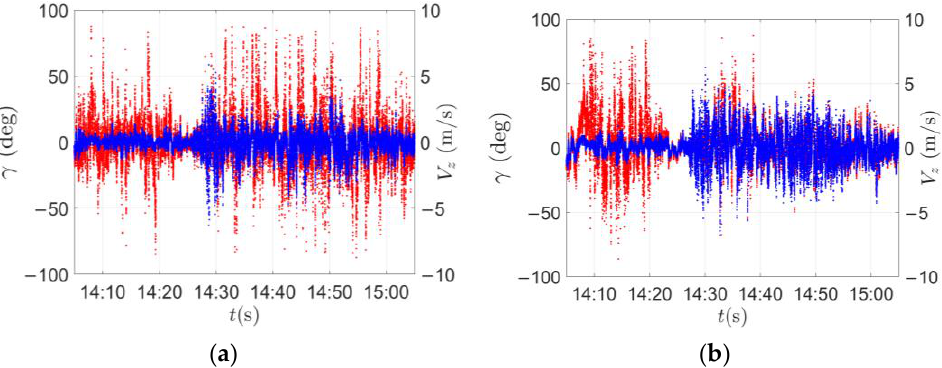
Figure 6. Vertical wind speed (blue) and wind attack angle (red) time history of the thunderstorm recorded at 16 m ( a ) and 64 m ( b ).